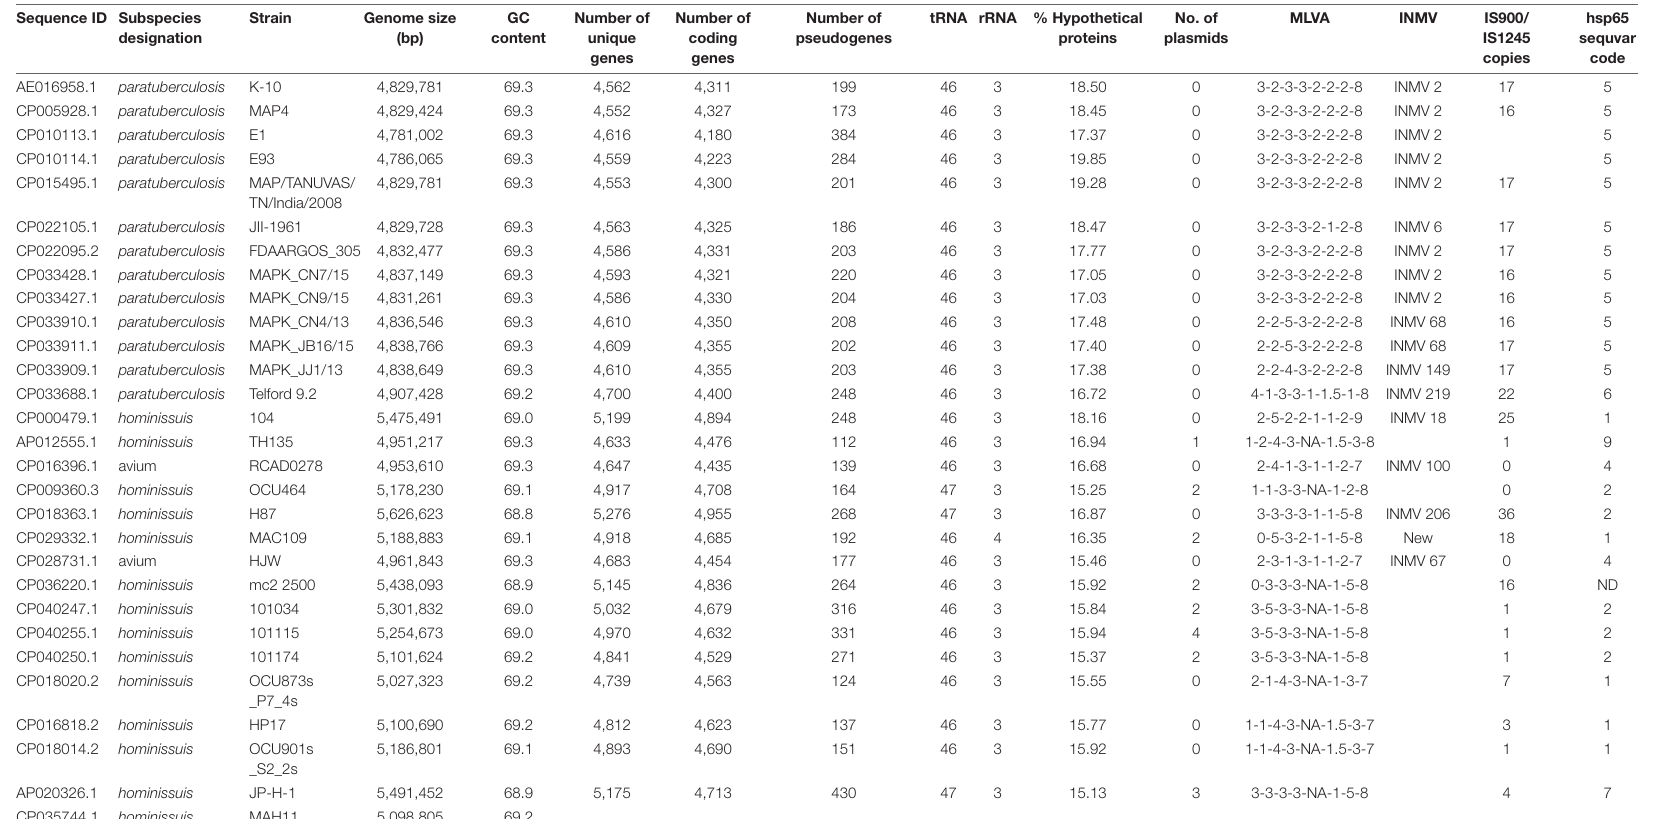
TABLE 3 | Characteristics of M. avium complex genomes in this study.